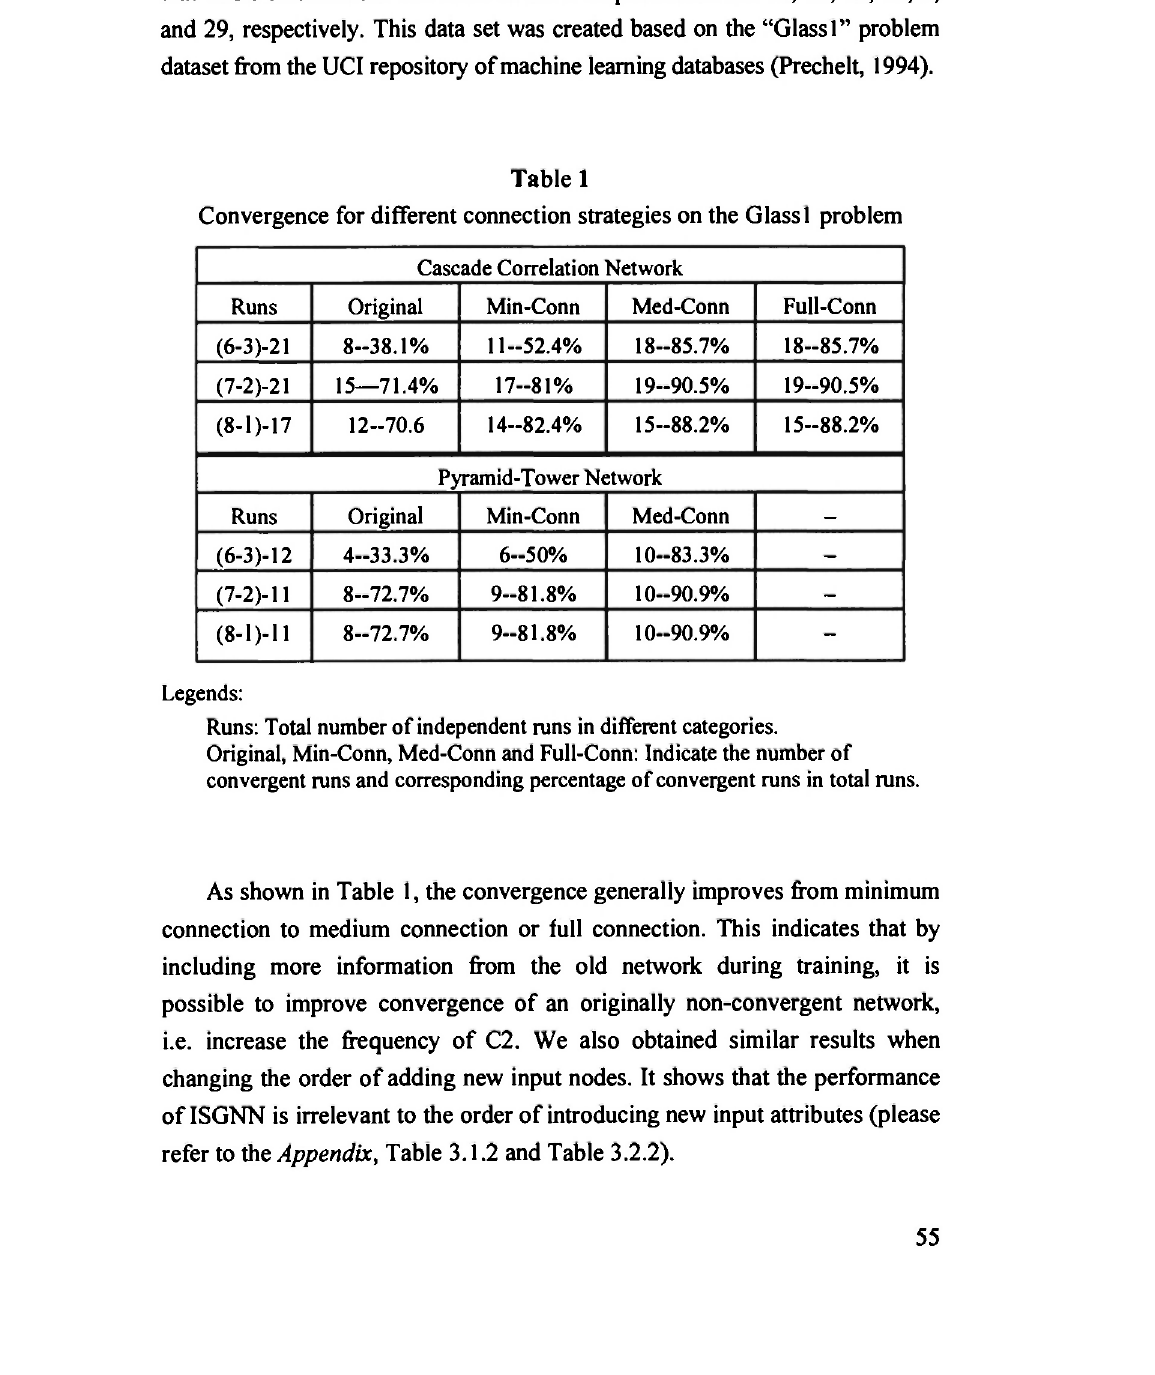
Convergence for different connection strategies on the Glass 1